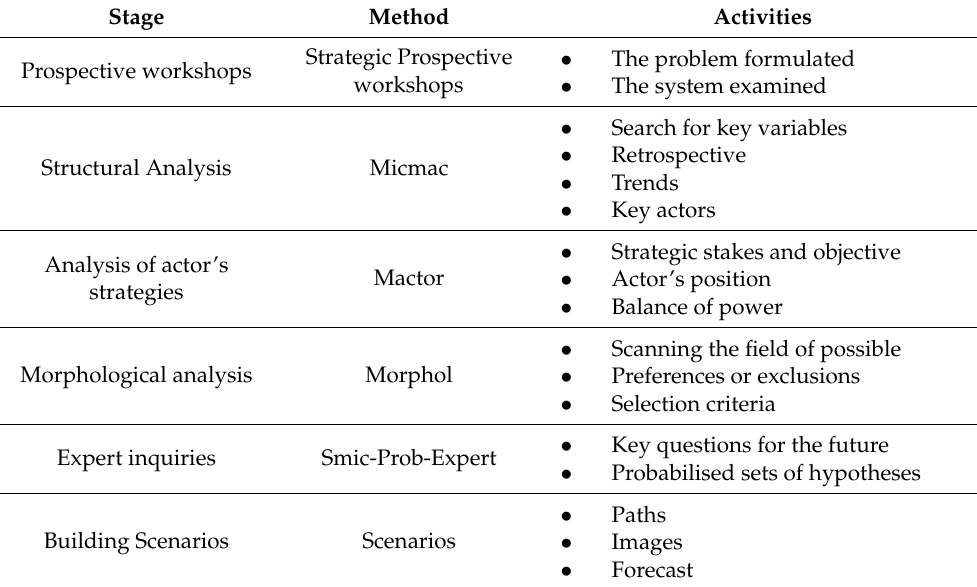
Table 1. The scenario method according to M. Godet. Source: [34] (p. 122).